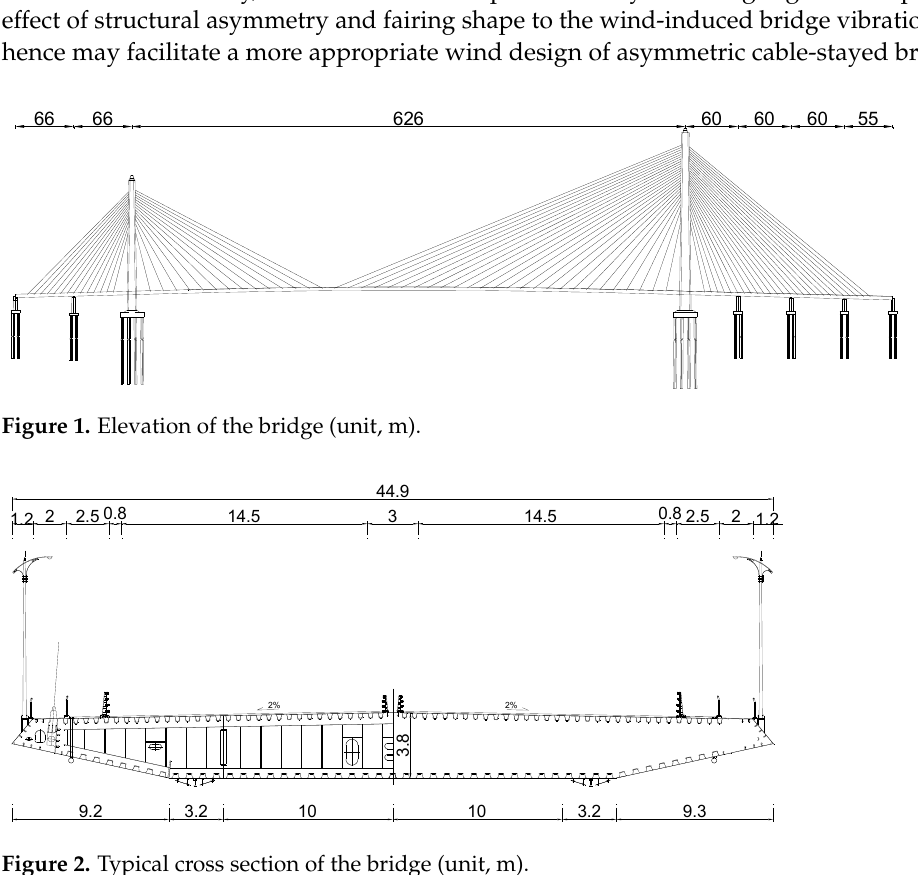
Figure 2. Typical cross section of the bridge (unit, m).